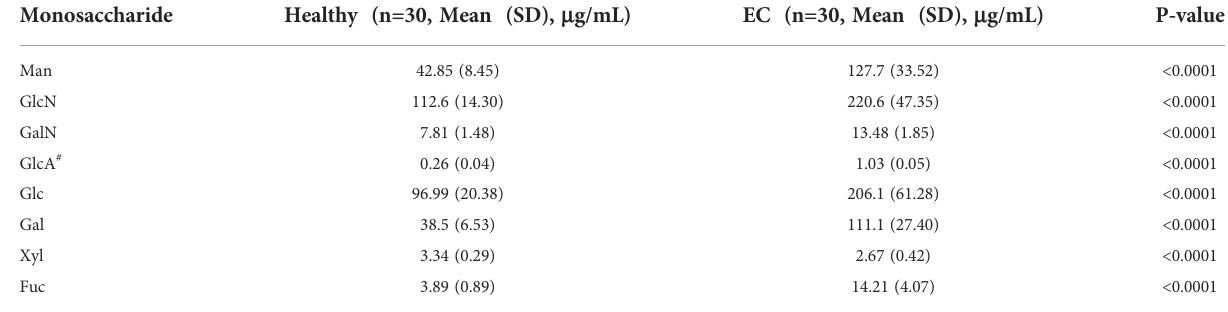
TABLE 4 Monosaccharide concentrations in endometrial cancer patients.